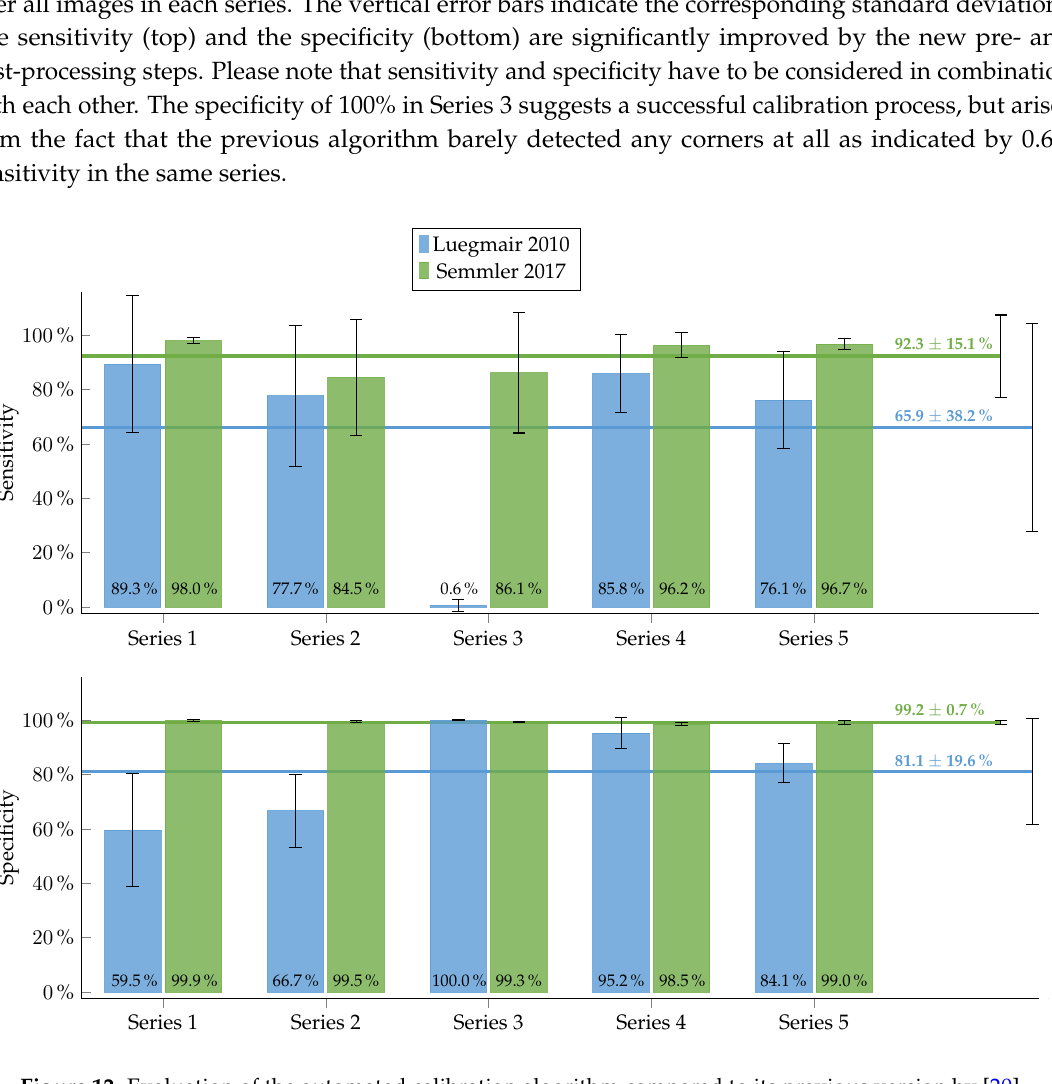
Figure 12. Evaluation of the automated calibration algorithm compared to its previous version by [20] including the sensitivity ( top ) and the specificity ( bottom ). The depicted bars represent the average value for each series while the vertical error bars indicate the standard deviation within each series. The horizontal lines represent the average value over all frames of all series and the error bars indicate the corresponding standard